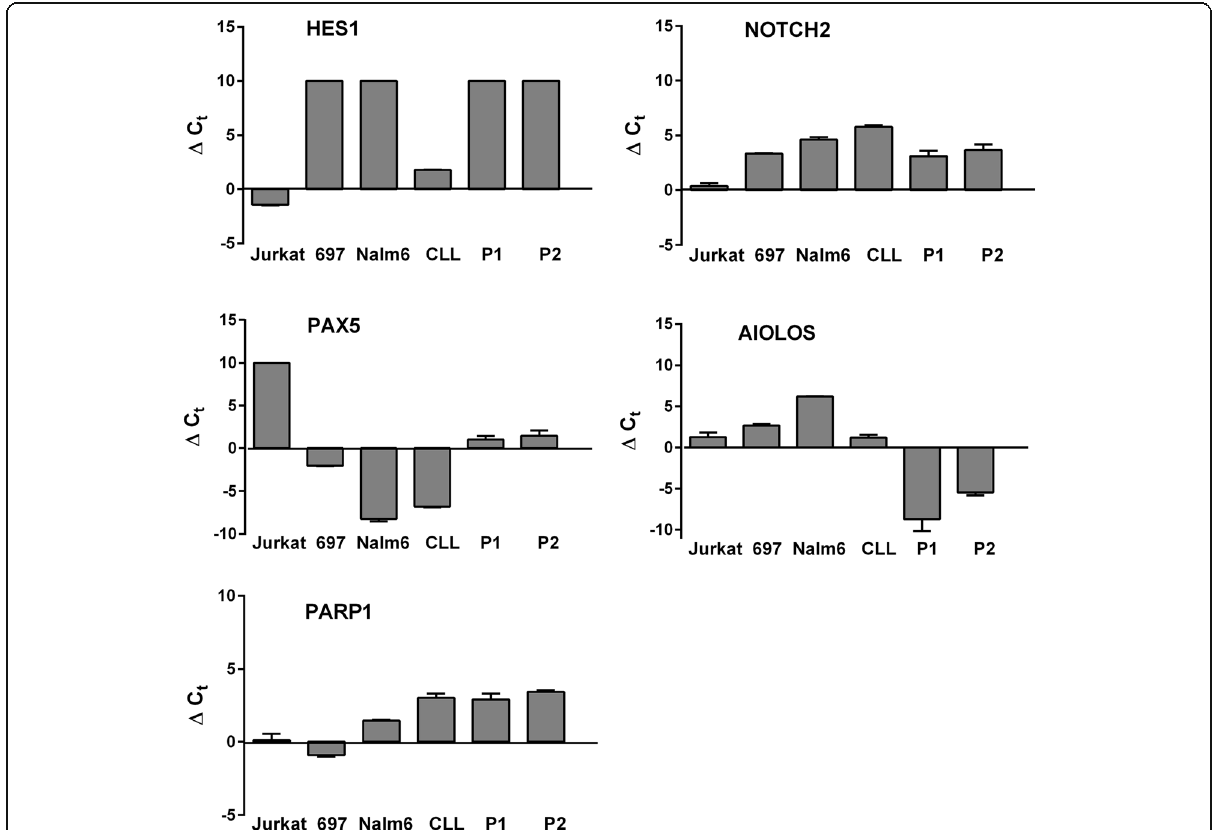
Fig. 4 Quantitative gene expression analysis in four human-derived cell lines and primary cells obtained from two patients (Sample 1 and 2). Cell lysates obtained from 500 cells were reversely transcribed with gene-specific primers and amplified for 15 cycles in multiple PCR reaction. For qRT-PCR reaction, the primer pairs were semi-nested. Expression levels are presented as Δ Ct